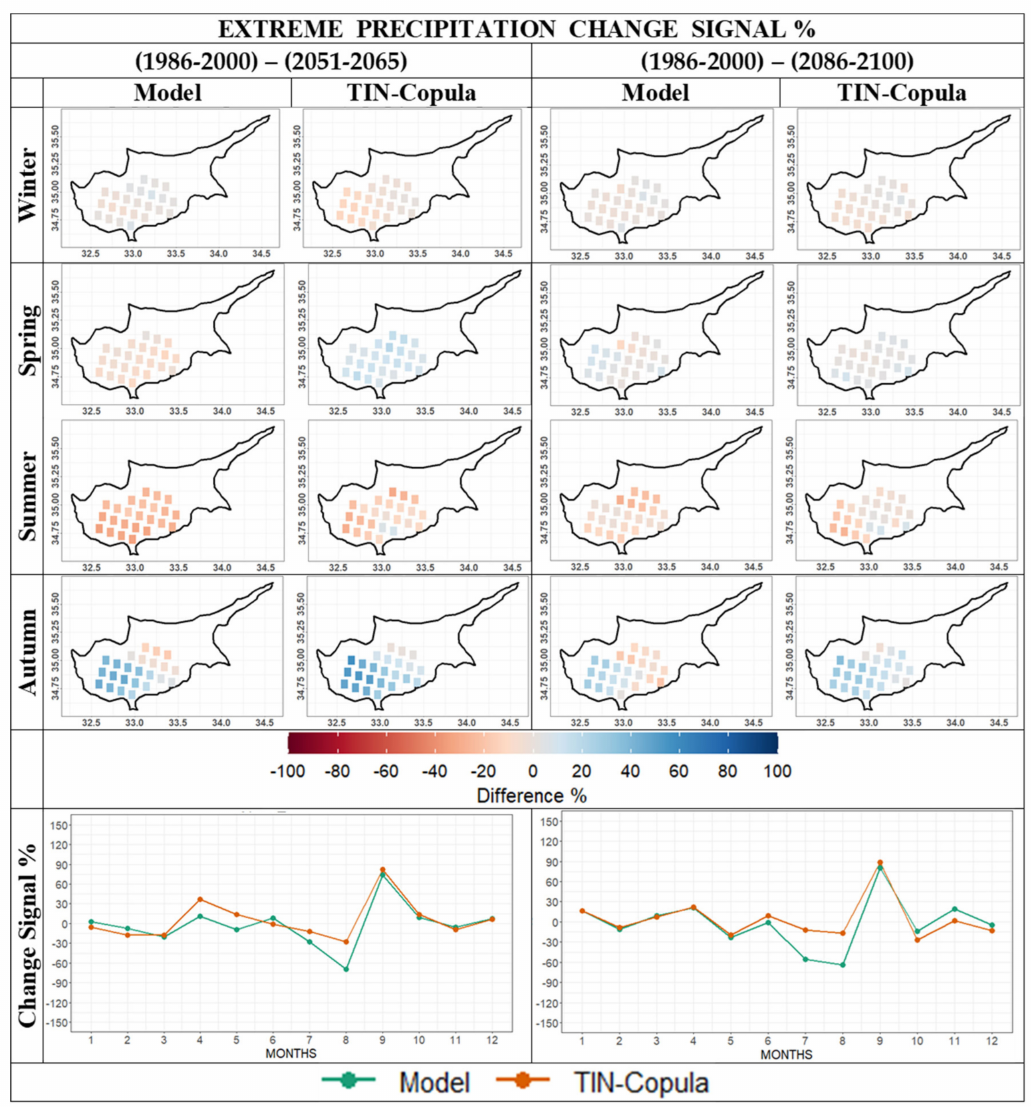
Figure 14. Climate change signal (CCS) of extreme precipitation, before and after the use of the TIN-Copula